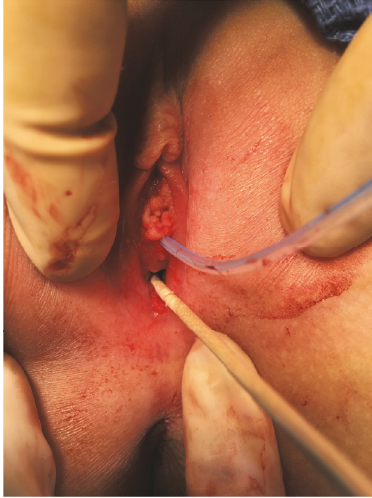
Figure 1: Photograph of the condylomas prior to excision.